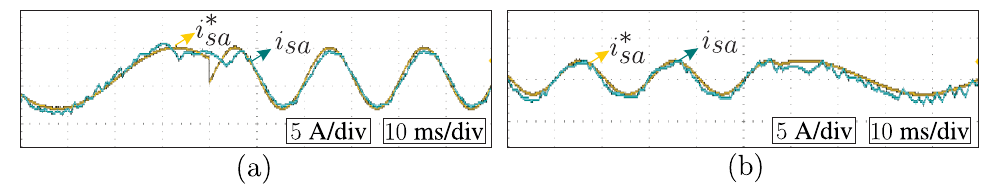
Figure 16. Current tracking performance compared to reference frequency changes. ( a ) Reference from 20 to 50 Hz. ( b ) Reference from 50 to 20